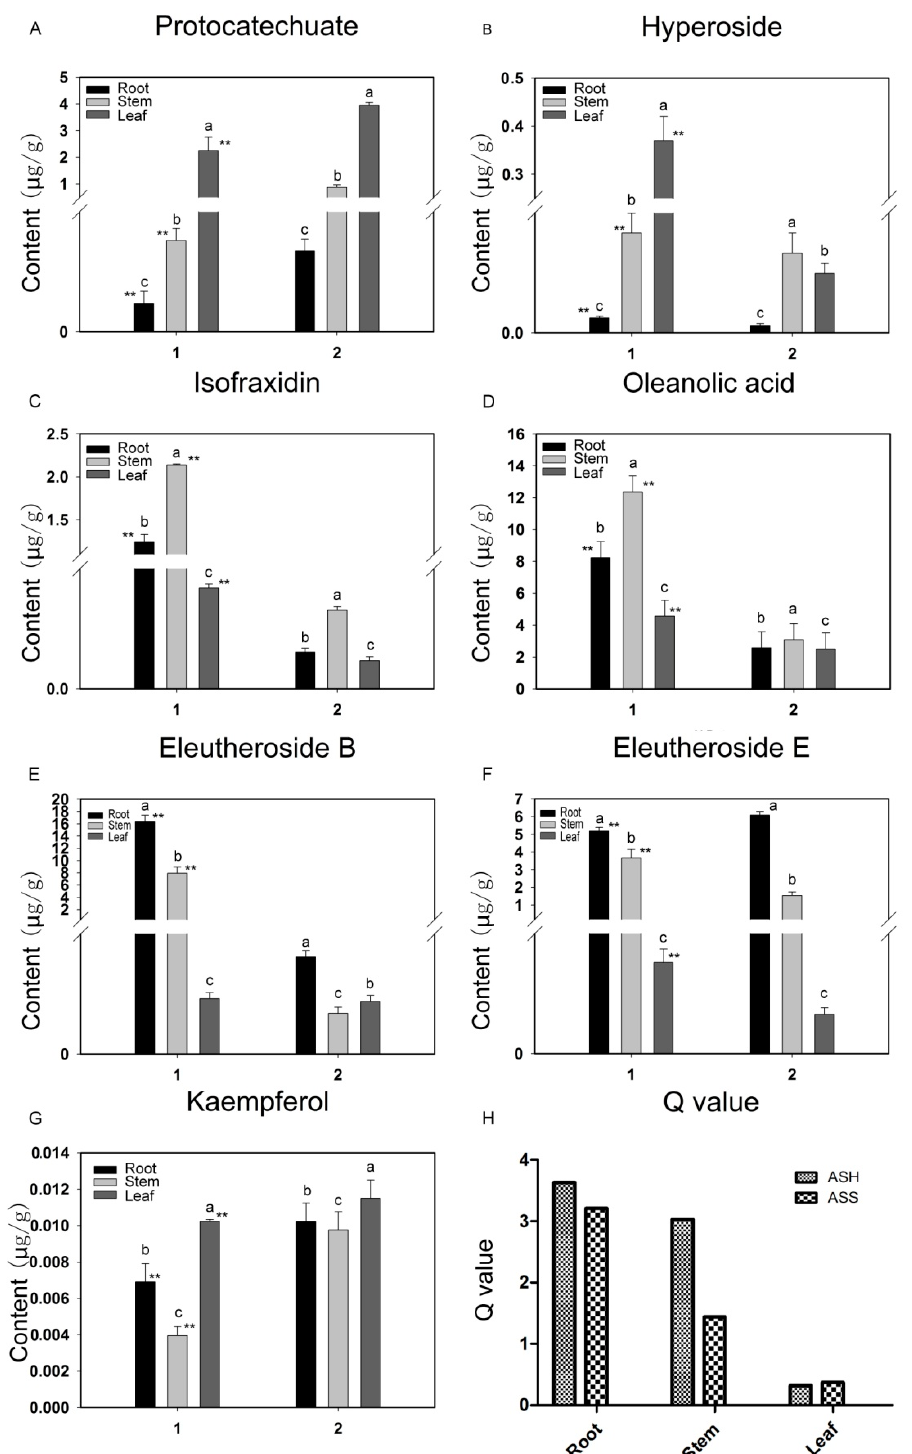
Figure 2. The contents of 7 major bioactive compounds in different parts of ASH and ASS ( A – G ) and the corresponding Q value ( H ). 1: ASH; 2: ASS. The letters a, b, c indicate significant differences between different tissues of the same plant ( p < 0.05); ** indicates significant differences between different tissues of different plants ( p < 0.01).